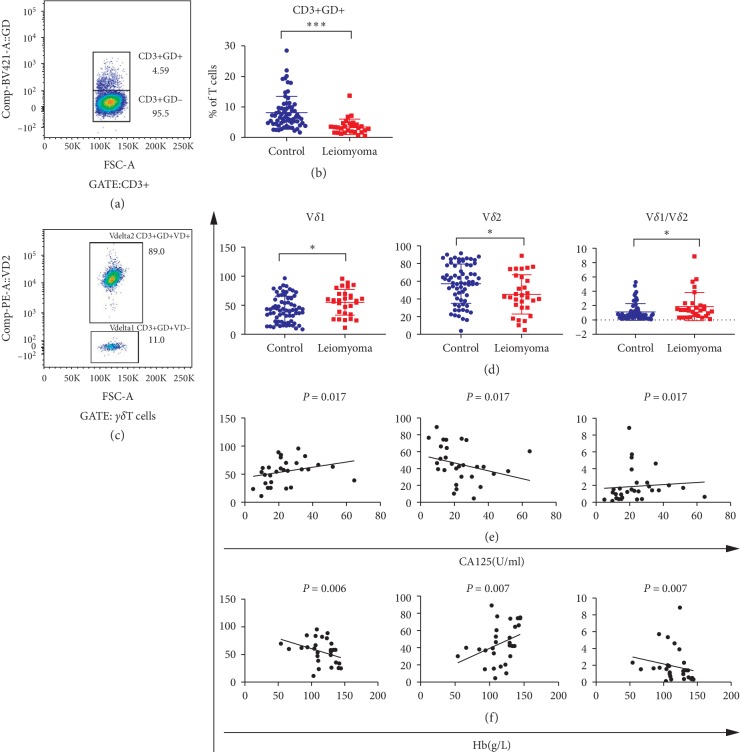
Distribution characteristics and significances of γδ T cells in 30 leiomyoma patients and 68 controls. (a, c) The flow analyses of γδ T cells, Vδ1+, and Vδ2+ cells, respectively. (b) The comparison of γδ T cells between patients and controls. (d) The comparison of Vδ1, Vδ2 cells, and the ratio Vδ1/Vδ2 between patients and controls. (e, f) The associations of Vδ1, Vδ2 cells, and the ratio Vδ1/Vδ2 with circulating CA125 and hemoglobin (Hb) level, respectively. ∗P < 0.05. ∗∗P < 0.01. ∗∗∗P < 0.001.